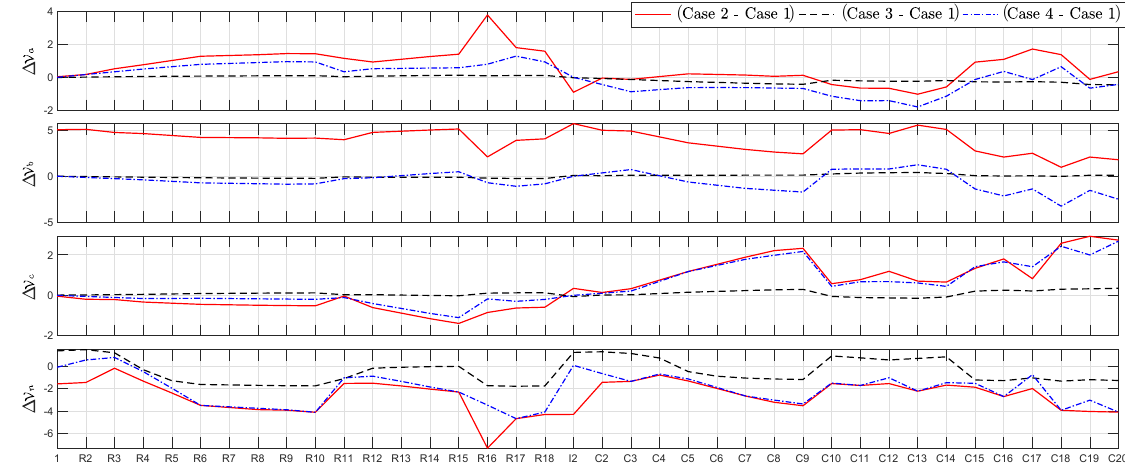
Figure 10. Differences between the phase-neutral and neutral bus voltages in Cases 2, 3, and 4 with respect to Case